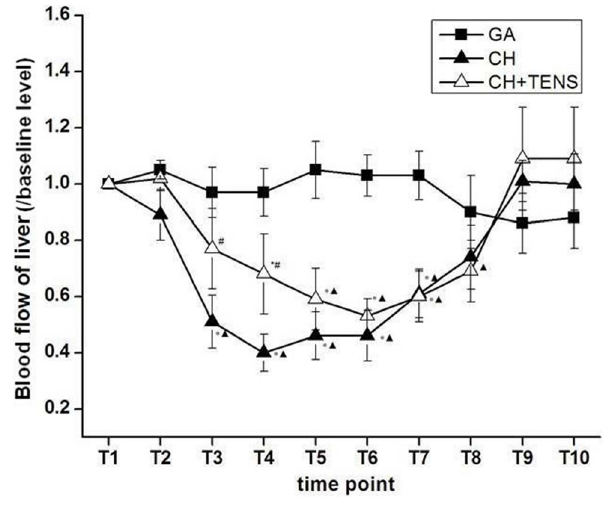
Figure 3. Blood flow to the liver during controlled hypotension (CH). TENS (2/100 Hz, bidirectional rectangle pulse with 0.6/0.2 ms pulse width,3–5 mA for more than 90 min) significantly prevented decreased perfusion to the liver from the beginning of CH to the end of the maintenance stage (T 1 to T 6 ). Data are presented as mean 6 standard error of the mean. * P , 0.05 vs. GA group, m P , 0.05 vs. basal level, # P , 0.05 vs. CH group, n=6 per group.